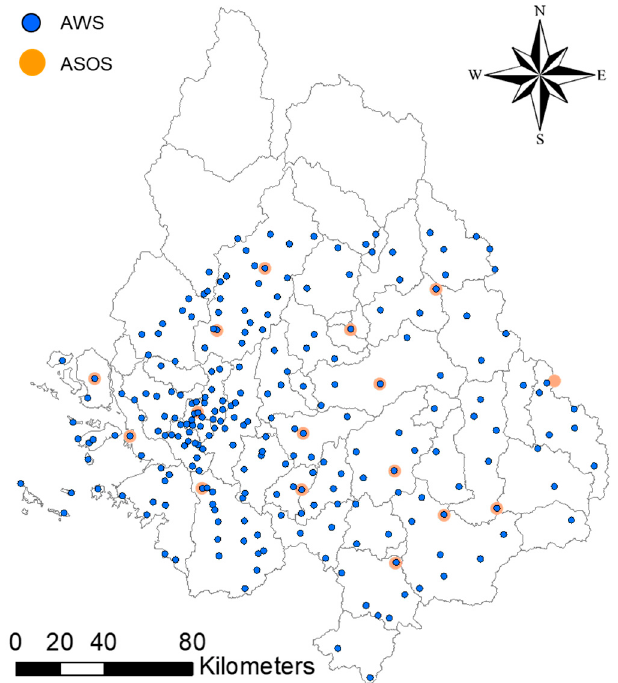
Figure 3. Locations of the automatic weather system (AWS) stations, blue circles, and automated surface observing system (ASOS) stations, orange circles, in the Seoul Capital Region. The catchment is divided into 48 sub-basins, as indicated with the gray lines.